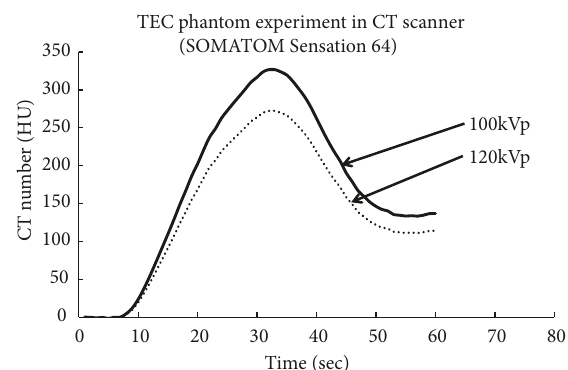
Figure 11: TECs of 120 kV and 100 kV obtained from conventional CTimages with lowkVp imaging. Ataninjection rateof 3.0mL/s, 75 mL (60 kg) was injected for 25 s, and the amount of the circulation wassetbyassumption.UnderlowkVpimaging,lowerkVp(100kVp) provides higher CT numbers for the contrast